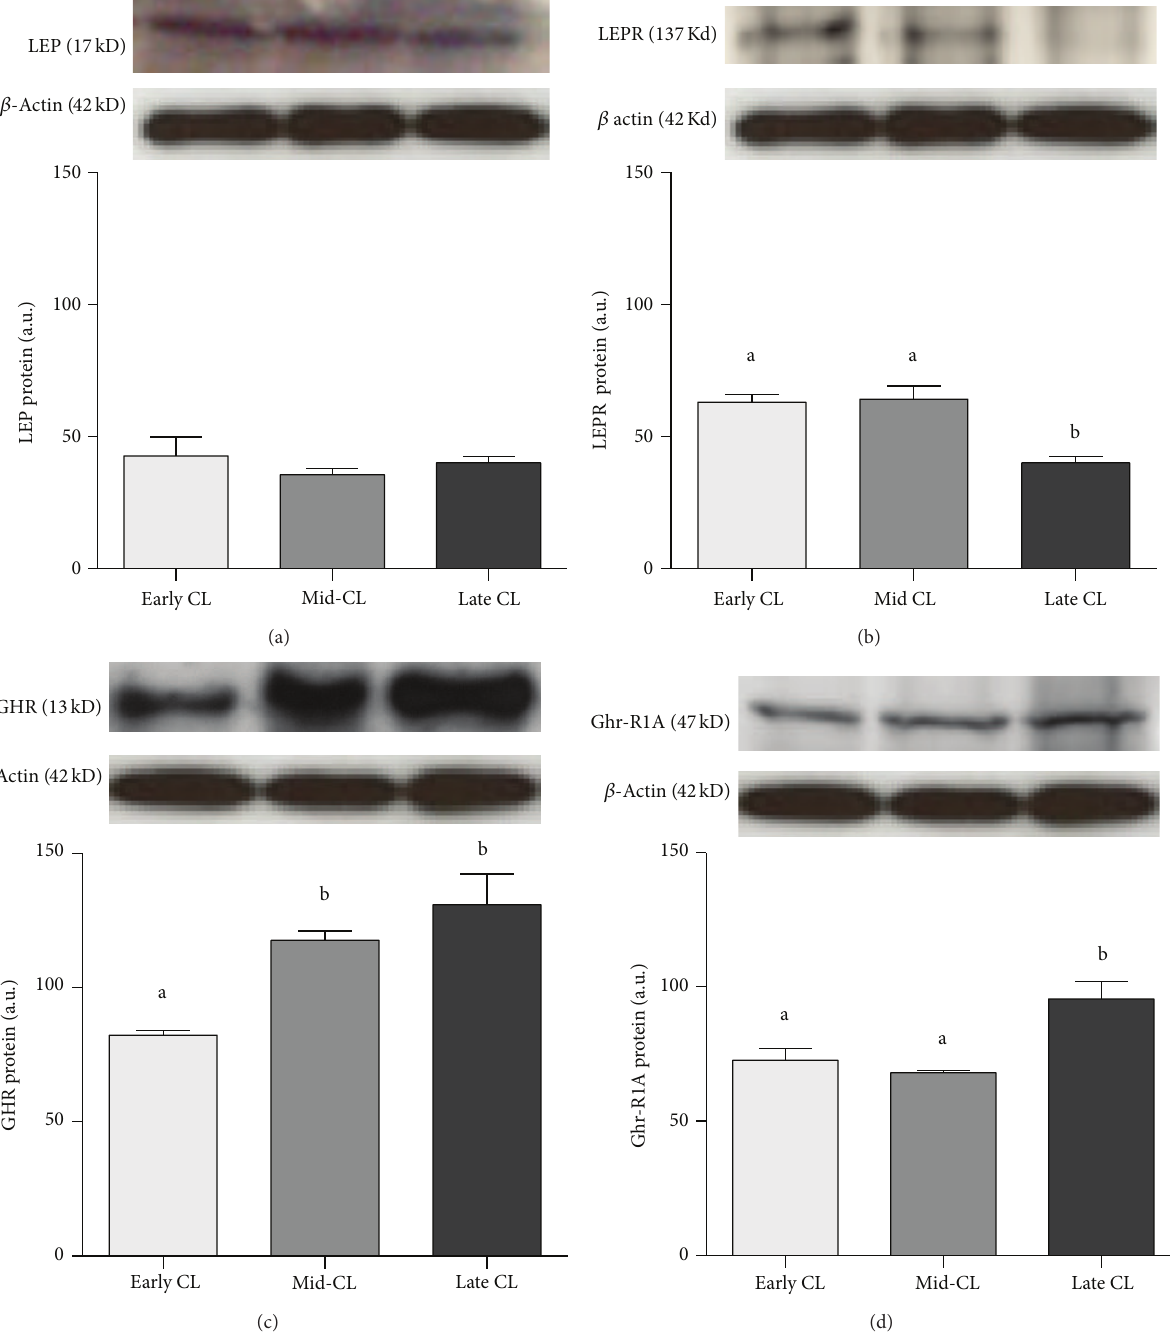
Figure 3: Protein expression of LEP (a), LEPR (b), GHR (c), and Ghr-R1A (d). Upper panels depict representative Western blotting ( 𝑛 = 4 ). Data normalized against 𝛽 actin density values. Bars represent mean ± SEM. Different letters indicate significant differences ( ∗ 𝑃 < 0.05 ; ∗∗ 𝑃 < 0.01 ).